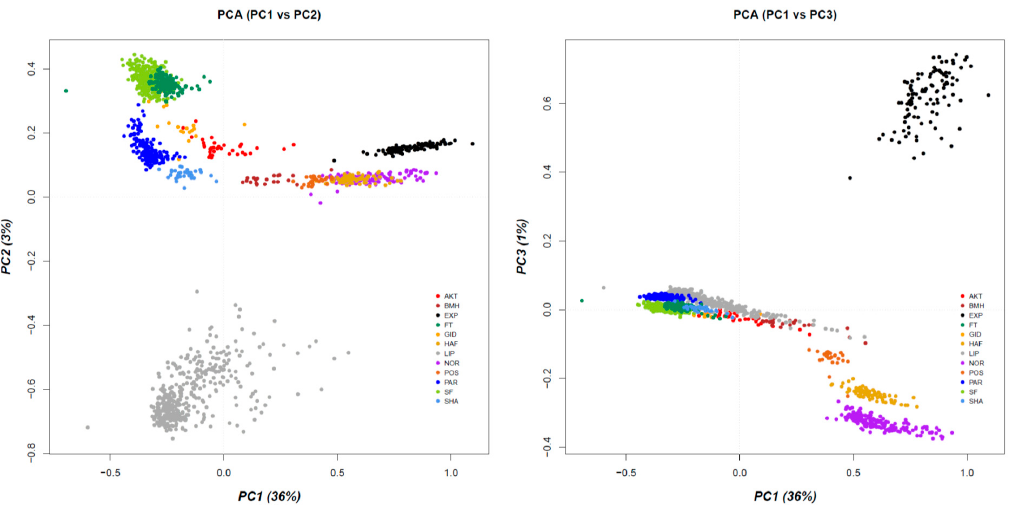
Figure 2. Principal component analysis (PCA) scatterplot illustrating the population stratification of 1,476 horses originating from 12 breeds. On the left visualization of PC1 versus PC2, together explaining 39% of genetic variance, and on the right visualization of PC1 versus PC3 together explaining 37% of variation, are presented. (AKT = Akhal Teke, BMH = Bosnian Mountain Horse, EXP = Exmoor Pony, FT = French Trotter, GID = Gidran, HAF = Haflinger, LIP = Lipizzan, NOR = Noriker, POS = Posavina, PAR = Purebred Arabian, SF = Selle Francais and SHA = Shagya Arabian).